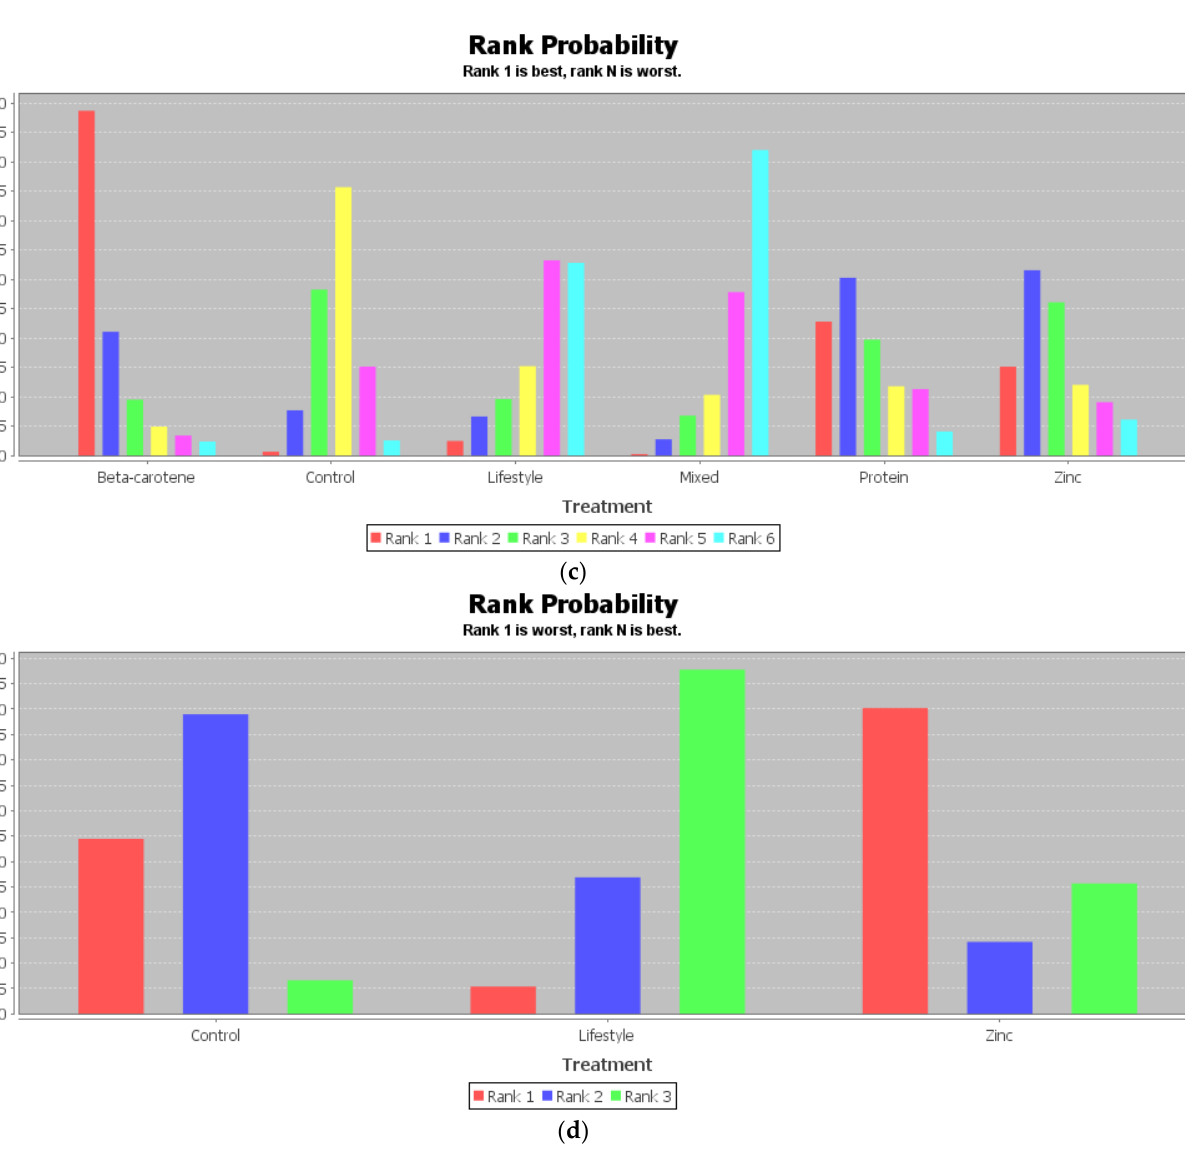
Figure 4. Ranking of measures and probabilities: ( a ) WBCs; ( b ) lymphocyte count; ( c ) CD4/CD8; ( d ) neutrophil count. Table 4. Ranking of measures and